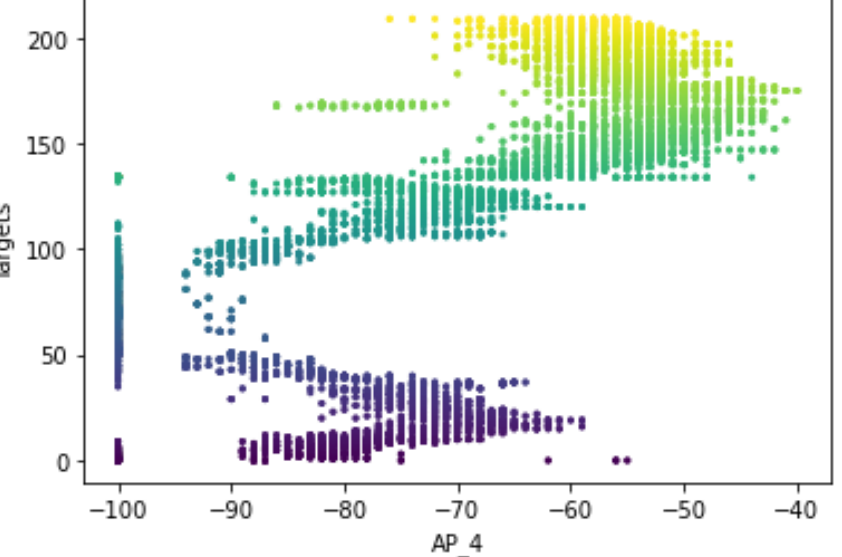
Figure 7. Distributions of RSS for Wi-Fi AP4 with their corresponding targets for dataset A.